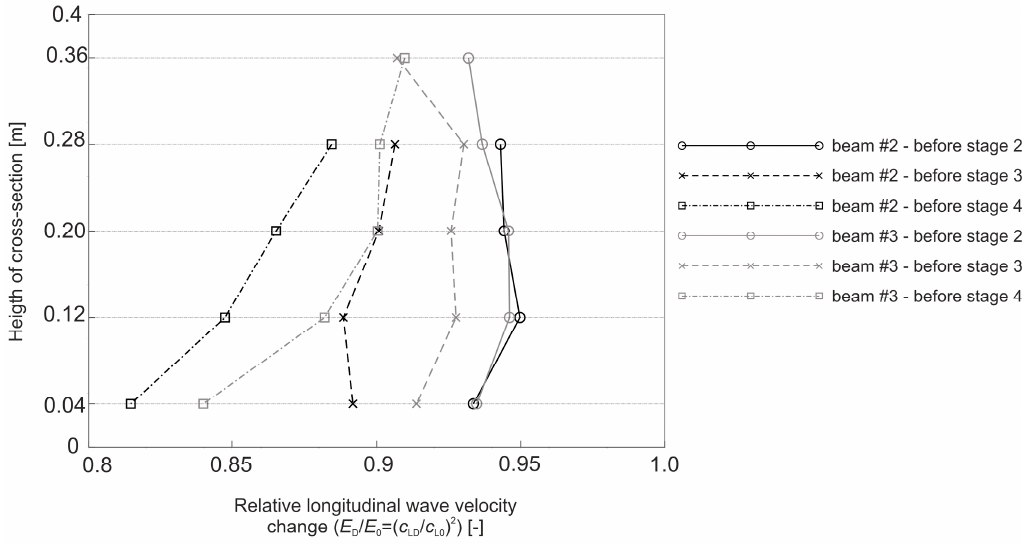
Figure 34. Summary diagram of the average changes of the velocity of the longitudinal waves along the height of the middle section of beams #2 and #3, calculated according to Equation (8).